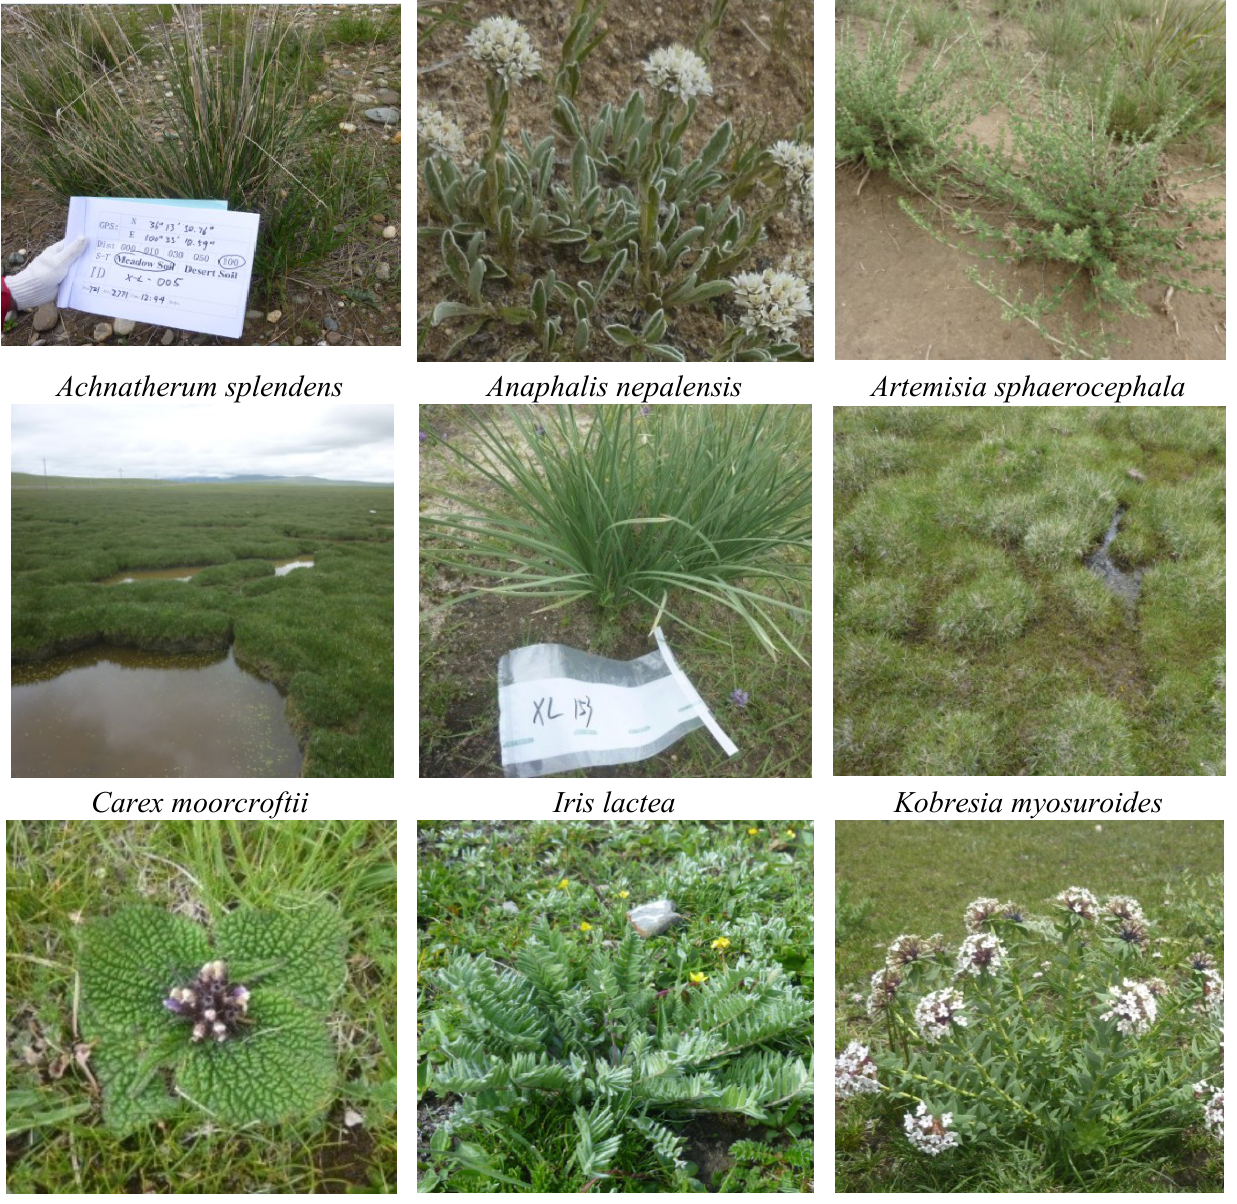
Figure 2. Photos of the selected grass